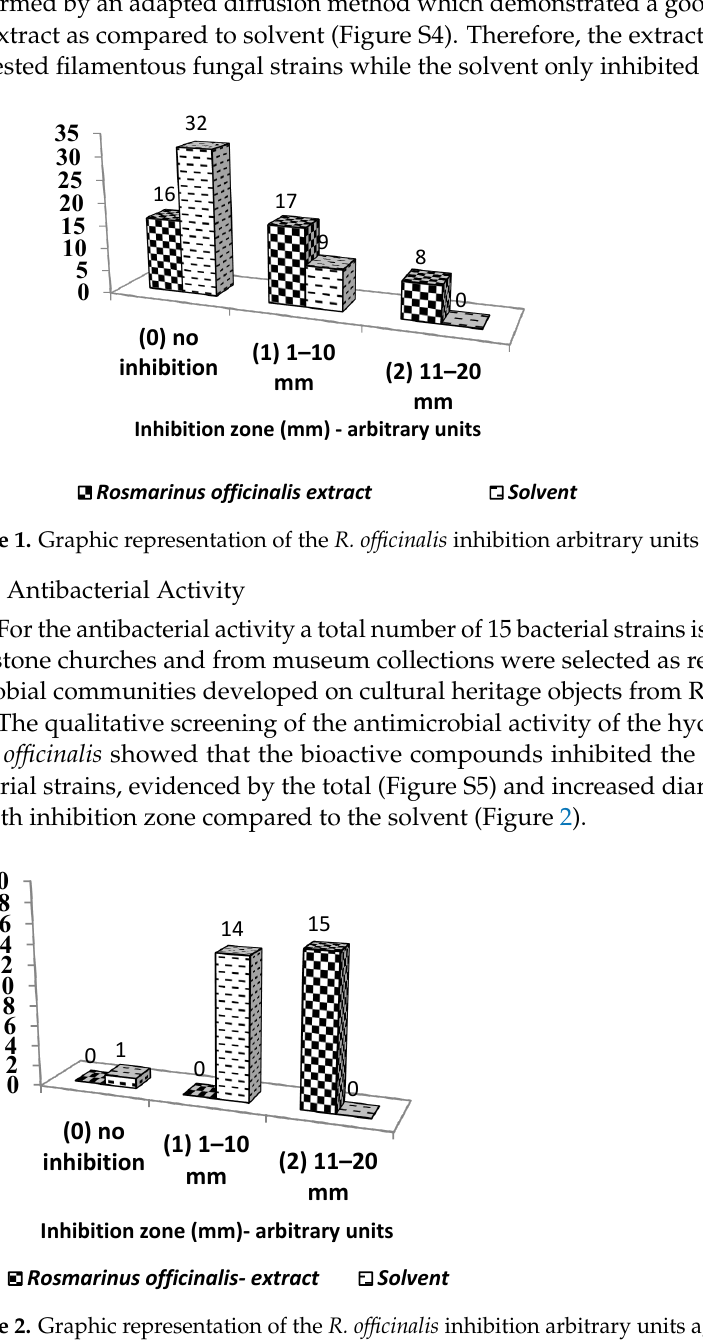
Figure 2. Graphic representation of the R. officinalis inhibition arbitrary units against bacterial strains.